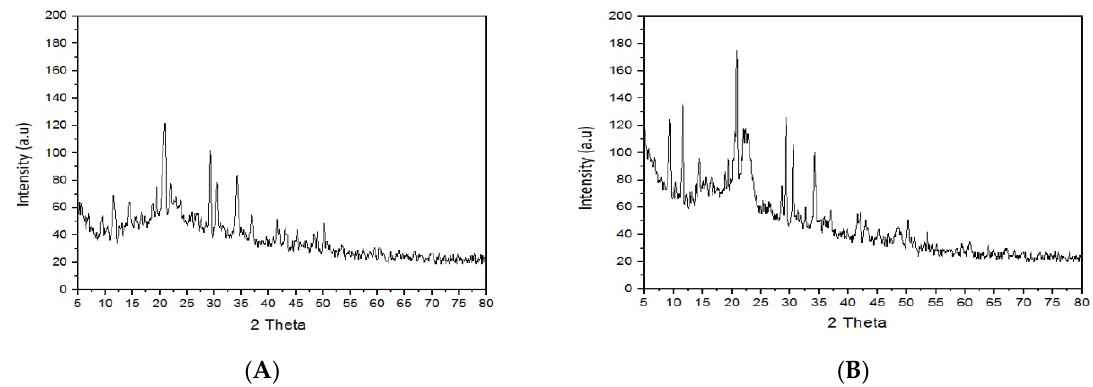
Figure 5. X-ray diffractrogram for pure drug ( A ) and for liquisolid compact ( B ).